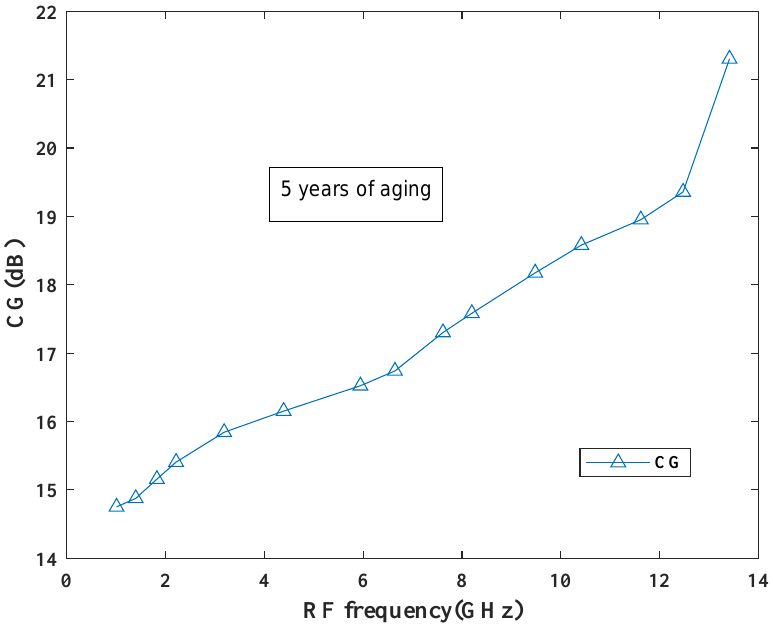
Figure 22. CG degradation